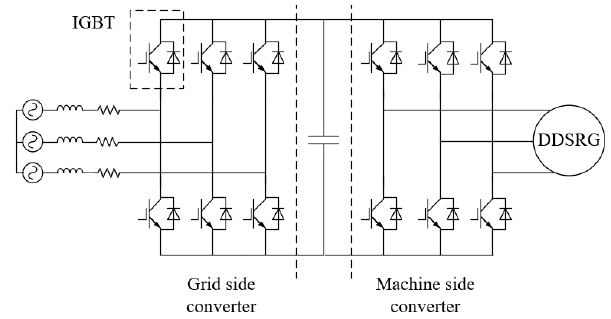
Figure 4. DDSRG power converter.